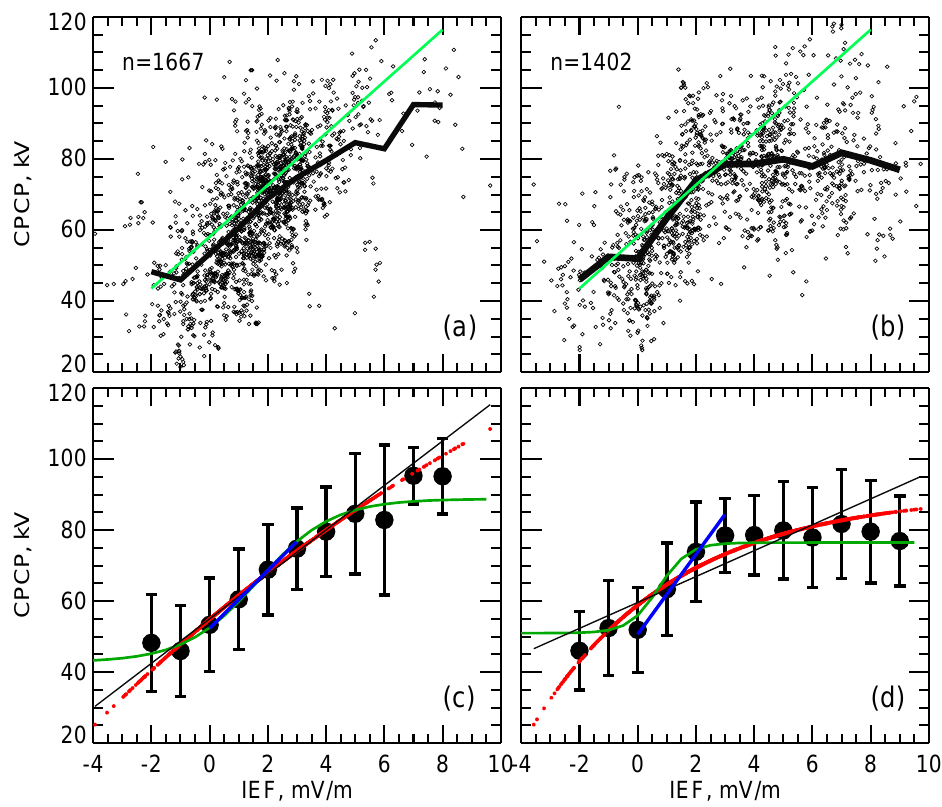
Fig. 1. Scatter plot of the cross polar cap potential (CPCP) inferred from SuperDARN radar measurements versus the interplanetary electric field (IEF) for (a) summer and (b) winter. Overlaid black thick lines connect the CPCP average values for IEF bins of 1-mV/m wide. The light green line is the linear relationship inferred by Liemohn and Ridley (2002) by using AMIE modeling. Panels (c) and (d) show various curves assessing the data of panels (a) and (b). Three different least square fits are considered: linear (black for the entire range of the IEF and blue for only growing part of the scatter plot), exponential (red) and sigmoidal-Boltzmann (dark green). The bin-averaged CPCPs (from panels a and b, respectively) and the corresponding standard deviations are also presented. Table 2. Parameters of the Boltzman fit CPCP = (A 1 − A 2 )/( 1 + exp [ ( IEF − x 0 )/1x ] ) + A 2 . A 1 , kV A 2 , kV x 0 , mV/m 1 x, mV/m Corr. coeff. St Dev, kV Kh (2008) 40.8 73.3 1.32 0.69 13.43 Summer 42.8